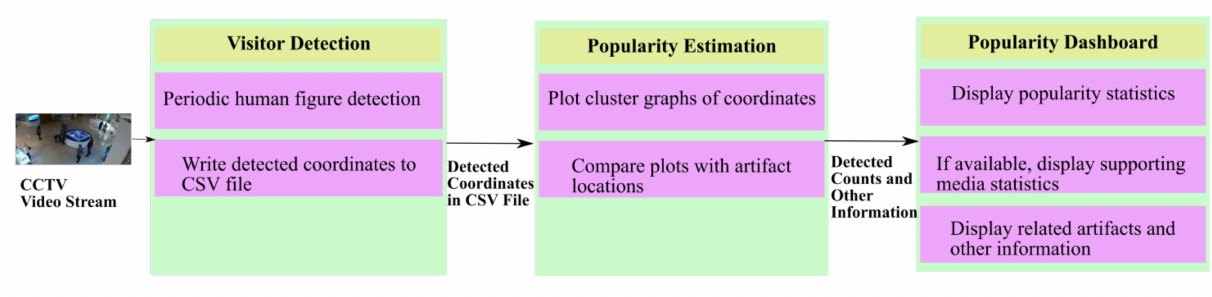
Figure 2. The architecture components and expected inputs and outputs between the modules of the proposed